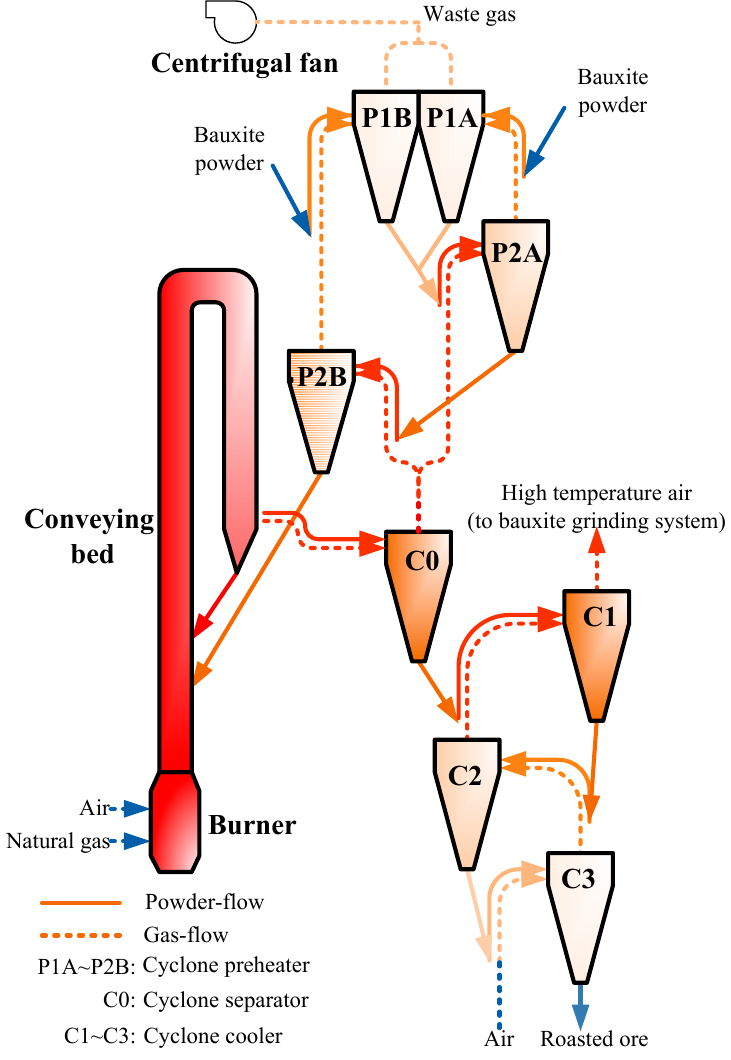
Figure 2. Flow chart of the roasting experiment in the conveying system for high ‐ sulfur bauxite.